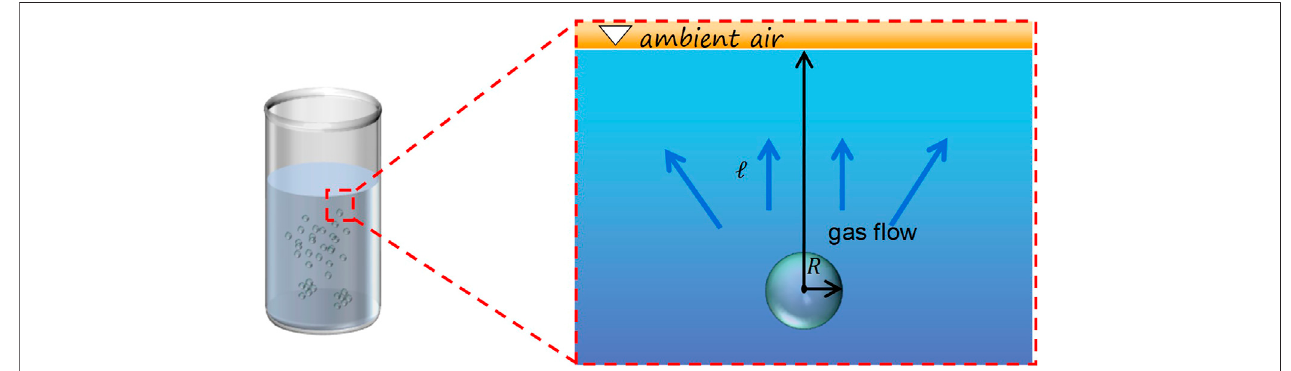
FIGURE1| Theschematicdiagramofasinglebulknanobubblestoredinanopensysteminwhichthereisgasexchangebetweenthebubbleandtheatmosphere. ℓ is the length of the nanobubble from air/water surface, which is also the distance of gas diffusion from the bubble to the air/water surface. The initial radius of the nanobubble is R .